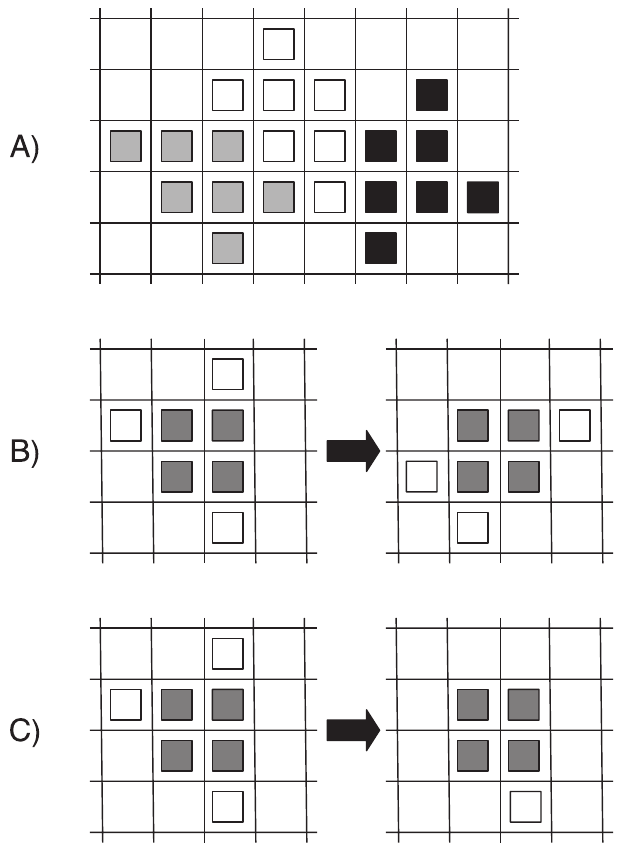
Figure 2. Multipixel Spatial Representation of Cells (A) Three cells on the spatial grid each occupying seven pixels. (B) Cell changes shape. The region of the cell that contains the nucleus, indicated by the four gray pixels, is structurally maintained; two border pixels move to new locations, and one border pixel (top right) displaces a nucleus pixel, which gets shifted to the right. (C) Cell rounding-up on fibronectin. The surface area in the presence of suprathreshold amounts of fibronectin is reduced with two border pixels moving into a quasi-third dimension above the cell.